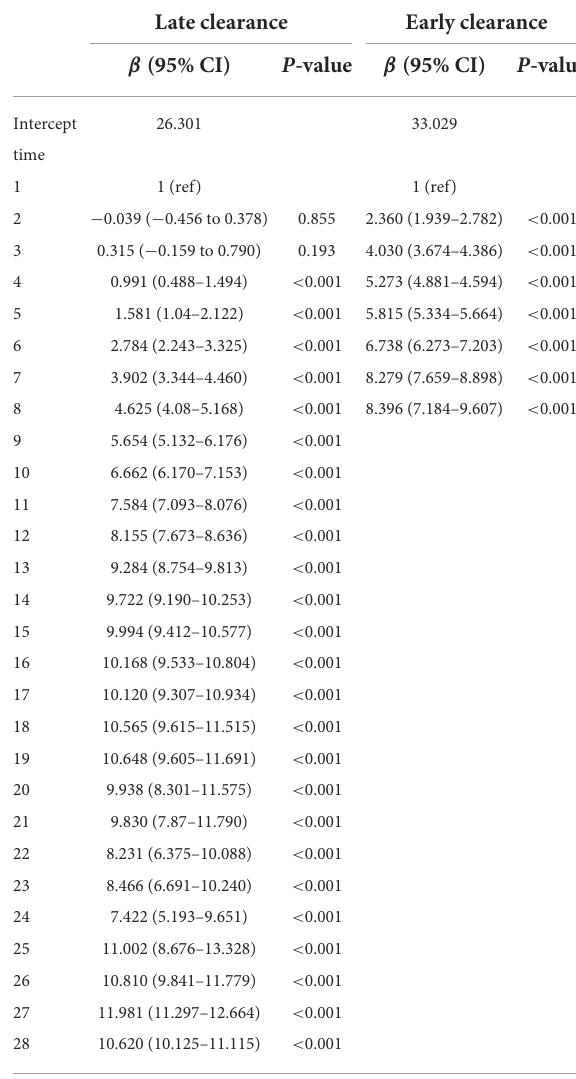
TABLE 8 Estimated factors associated with Ct values of N gene with times by